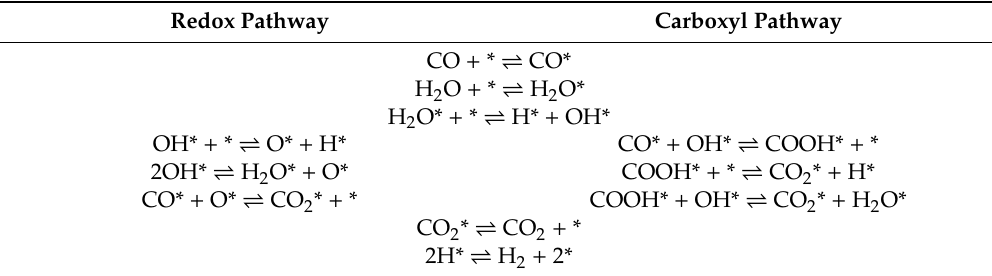
Table 1. Redox and carboxyl pathways for the water–gas shift reaction (WGSR). Reprinted with permission from [53]. Copyright (2008) American Chemical